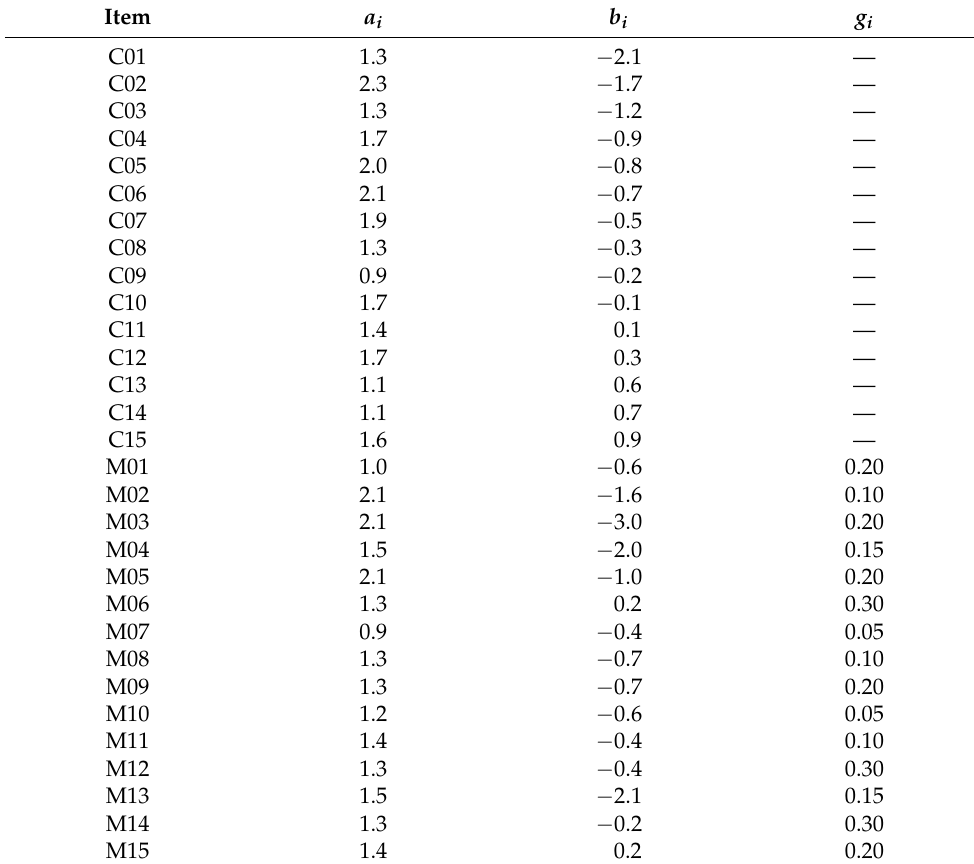
Table 1. Simulation study: data-generating item parameters in the 4PGL